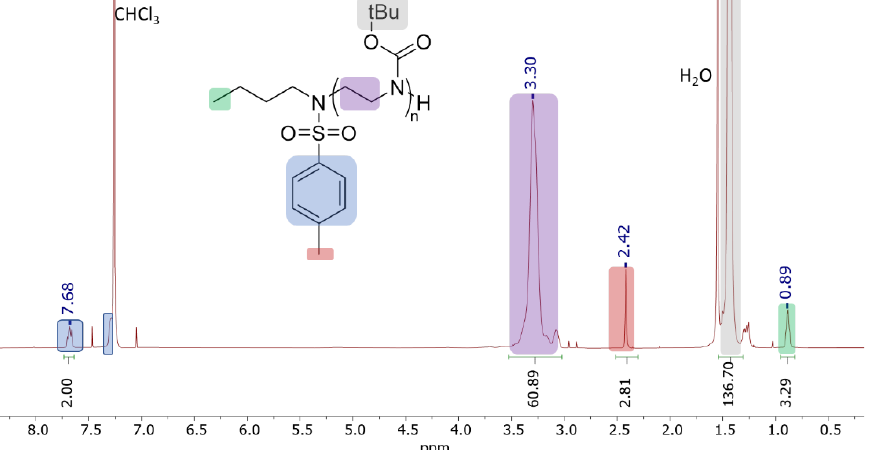
Figure 1. 1 H NMR (CDCl 3 ) spectrum of poly( BocAz ) formed from the reaction between 20 equiva- lents of BocAz and 1 equivalent of BuN(K)Ts. 1 H NMR spectroscopic end-group analysis reveals a degree of polymerization of about 15.2 repeat units. This is based on the relative integration of the signals attributed to the phenyl protons on the initiator and the polymer methylene signals. Table 1. The AROP of BocAz at various [ BocAz ]:[BuN(K)Ts] ratios.